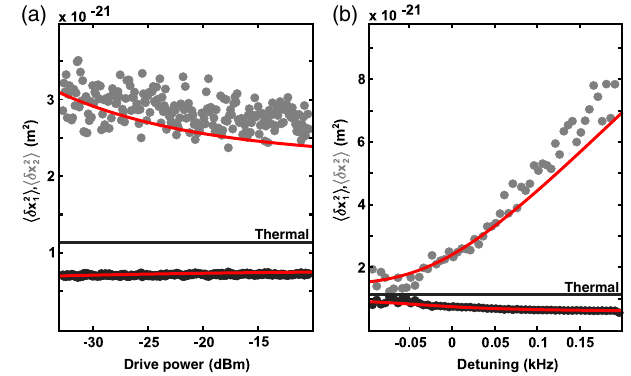
FIG. 3. Variance of in-phase and quadrature fluctuations around the stable state of forced vibrations as a function of (a) drive power and (b) detuning. Black and gray dots show the in-phase and quadrature values extracted from the experimentally deter- mined satellite area ratio, respectively, whereas red lines show the corresponding theoretical model including the partial overlap of the peaks (no free parameters; see SM [45]). Black lines in (a) and (b) indicate the thermomechanical fluctuations at 293 K.